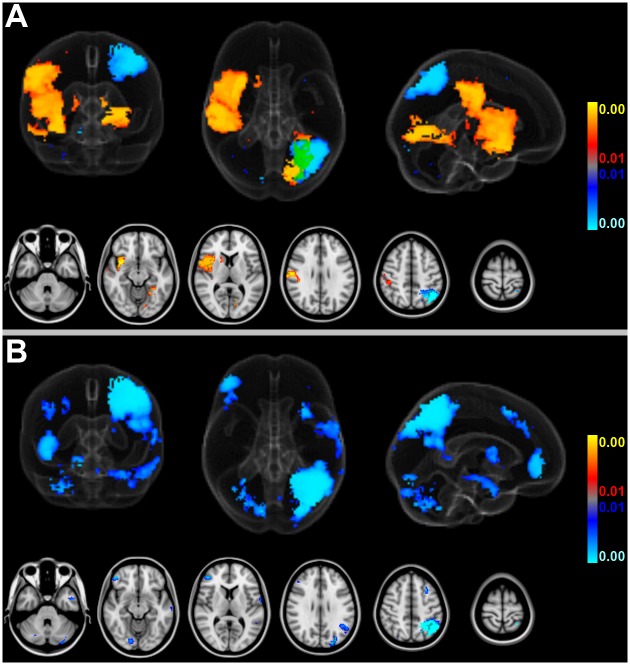
Differences of infarct locations: New AF versus no AF.(A): New AF was, compared to patients without AF, associated with ischemic lesions in a) the right (peri-) insular cortex and the caput of the right caudate nucleus and b) in the left PCA territory. Patients without AF had significantly more often strokes in the left parietal lobe than patients with new AF. (Red-to-yellow: areas significantly more often associated with strokes in patients with new AF vs. without AF, blue-to-lightblue: vice versa and green: overlap projections; thresholded at FDR-corrected q = 0.01; age and gender were included as covariates of no interest, with infarct volume unaccounted for in this analysis). (B): Including infarct volume into the analysis revealed that no specific brain region was associated with significantly more stroke lesions in patients with new AF compared to patients without AF. Vice versa, patients without AF still had more often left parietal involvement compared to patients with new AF. (Red-to-yellow: areas significantly more often associated with strokes in patients with new AF vs. without AF [none], blue-to-lightblue: vice versa; FDR-corrected q = 0.01; with removal of the confounding effect of cubic root infarct volume normalized for brain size, age and gender).